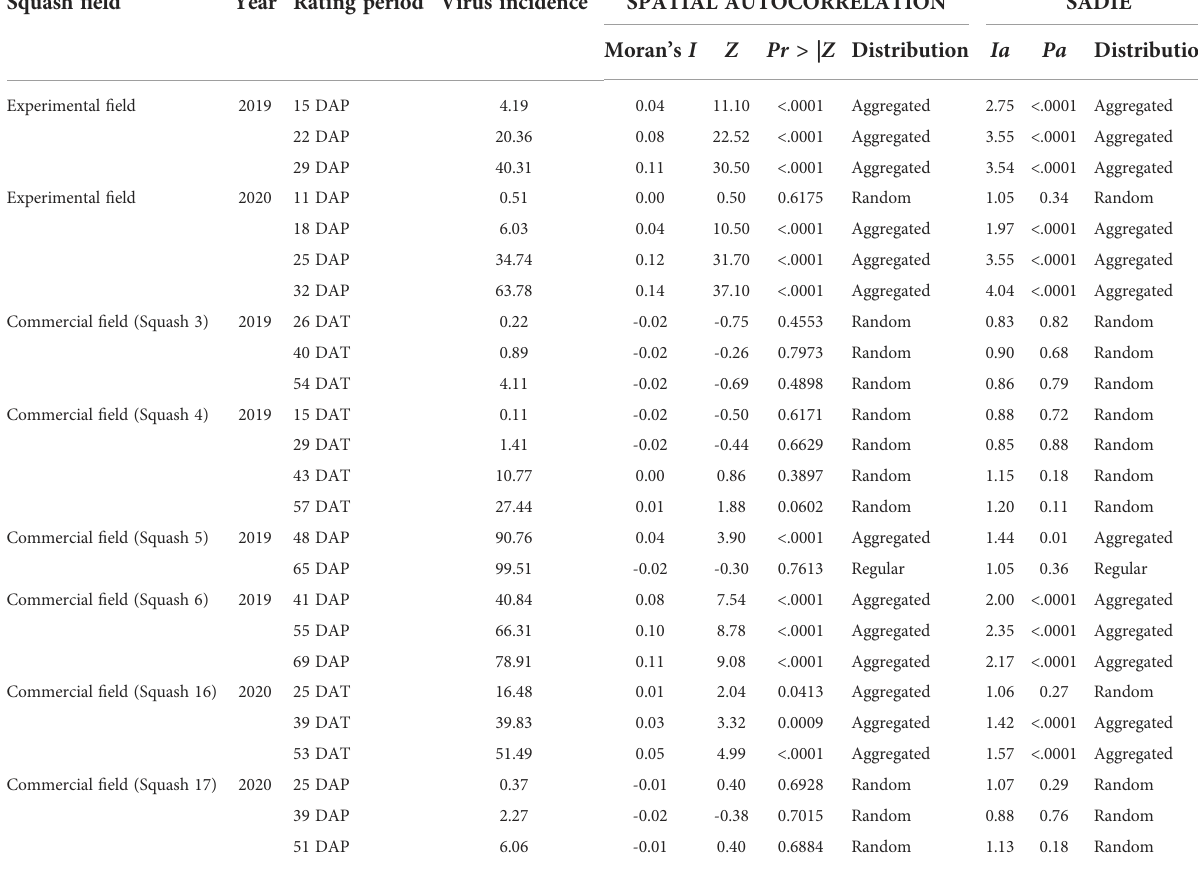
TABLE 7 Two-dimensional spatial distribution of WTVC in yellow squash fi elds based on spatial autocorrelation analysis and SADIE analysis based on WTVC incidence per fi eld and per rating period. Squash fi